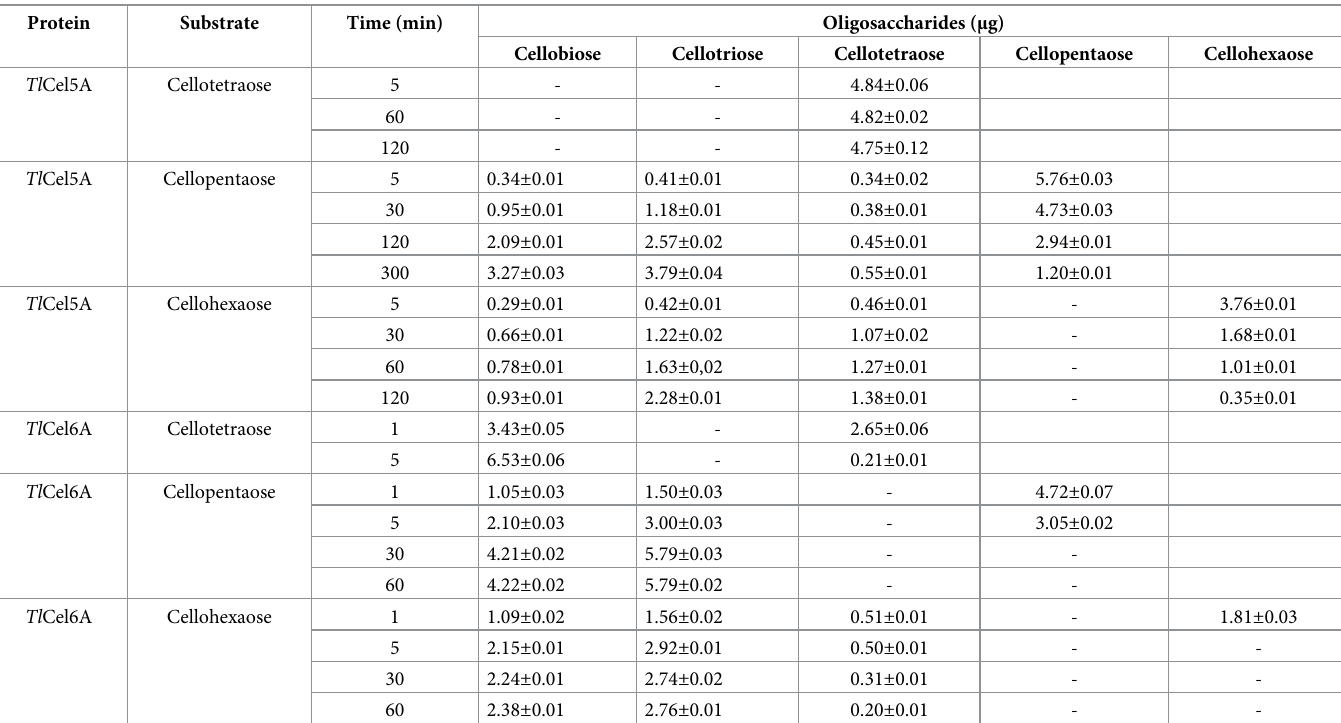
Table 2. Hydrolysis product analysis of cellooligosaccharides by Tl Cel5A and Tl Cel6A. Protein